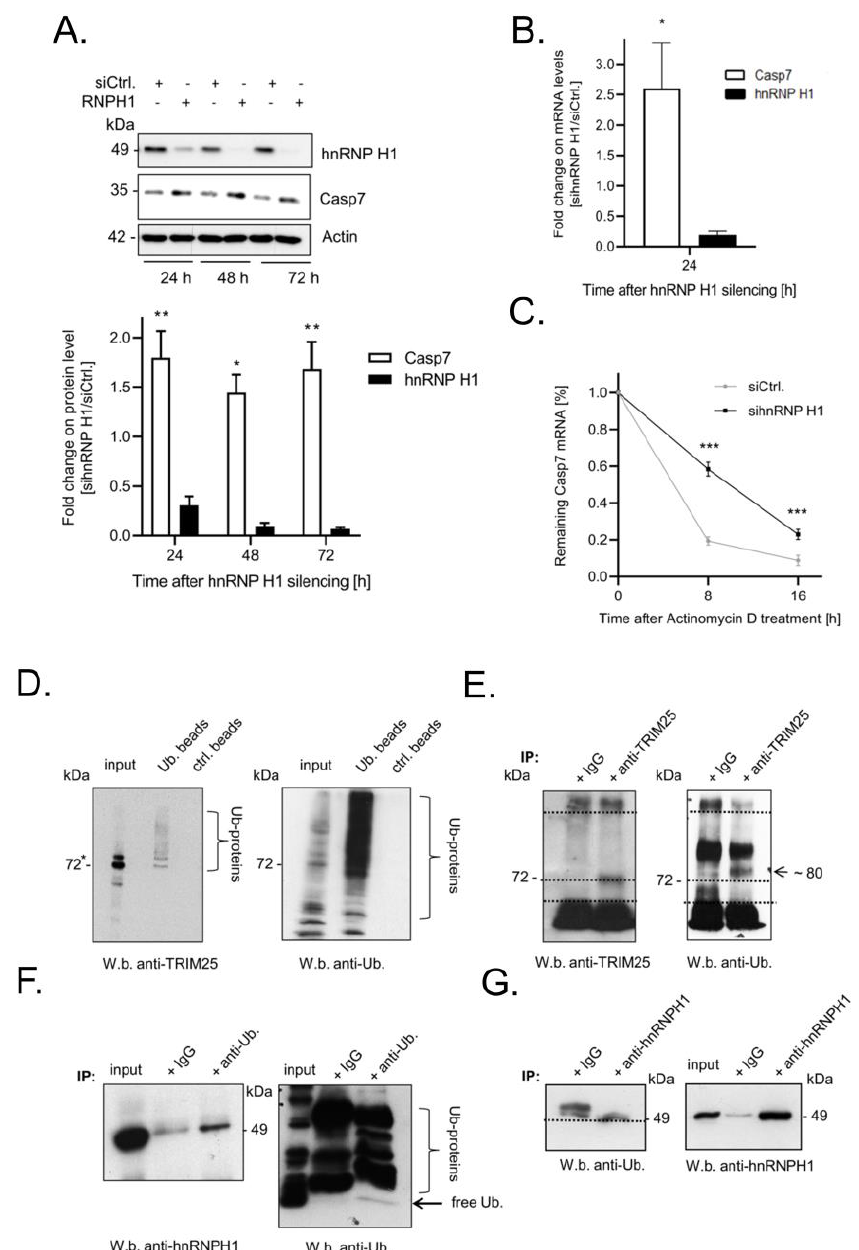
Figure 5. ( A – C ) Silencing of hnRNPH1 enhances caspase-7 expression via increasing the stability of caspase-7 mRNA. ( A ) Time-dependent changes in caspase-7 protein levels after hnRNPH1 knockdown. Subconfluent RKO cells were transfected with control siRNA duplexes (open bars) or with siRNA duplexes of hnRNPH1 (black bars) for the indicated time periods before the content of caspase-7 (open bars) was monitored by Western blot analysis. β -actin was used as a loading control. Data in the lower panel represent means ± SD (n = 3) * p ≤ 0.05, ** p ≤ 0.01 caspase-7 contents in sihnRNPH1 vs. control siRNA transfectants set as one-fold. ( B ) Steady-state mRNA levels of caspase-7 (open bar) after siRNA-mediated hnRNPH1 (black bar) knockdown were measured by quantitative real-time PCR in relation to 18S RNA levels and are shown as a ratio of the mRNA contents in sihnRNPH1 vs. control siRNA transfectants, which were set as one-fold. Data represent means ± SD (n = 3), * p ≤ 0.05. ( C ) Increased stability of caspase-7 mRNA after silencing of hnRNPH1 in RKO cells. Twenty-four hours after siRNA transfection, cells were washed before being treated with actinomycin D (5.0 µ g/mL). The remaining mRNA contents were normalized to 18S RNA at